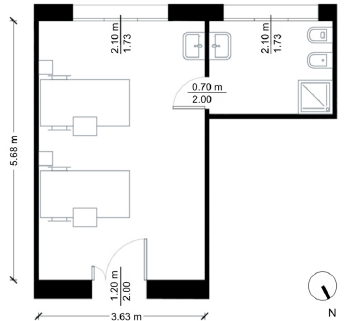
Figure 1. Floor plan of the patient room analysed.